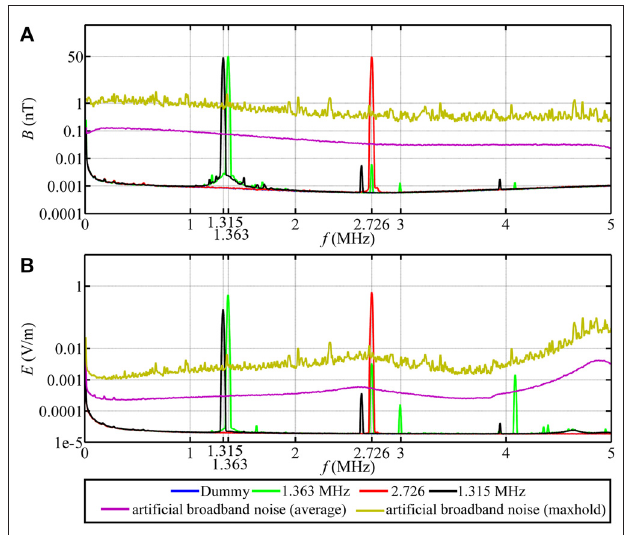
FIGURE 3 | Magnetic and electric field measurements of test conditions in spring 2012, autumn 2013 and spring 2014 . Traces in (A,B) show, respectively, the magnetic ( B ) and electric ( E ) components of the narrow-band electromagnetic fields and the artificial broadband noise as a function of frequency ( f ). The narrow-band magnetic fields had a peak intensity of 48 nT. The intensity of the broadband noise is shown twice: the purple line is the average (root mean square) intensity and the yellow line is the 40 min max-hold intensity and is directly comparable to the spectra shown in Engels et al.